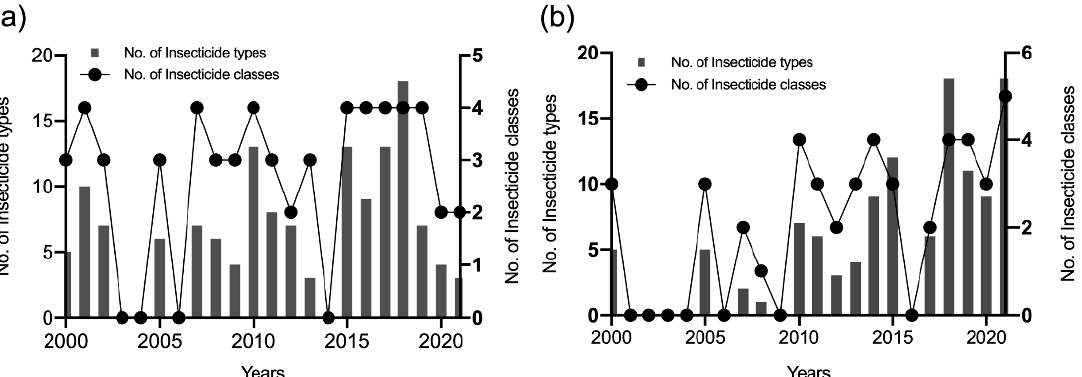
Figure 3. Types and classes of insecticides tested in Aedes mosquitoes. ( a ) Ae. aegypti . ( b ) Ae. albopictus.